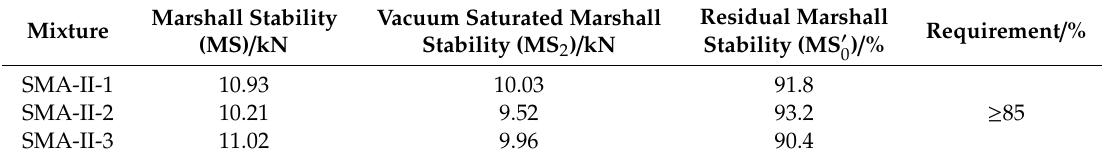
Table 16. Results of vacuum saturated Marshall stability test.